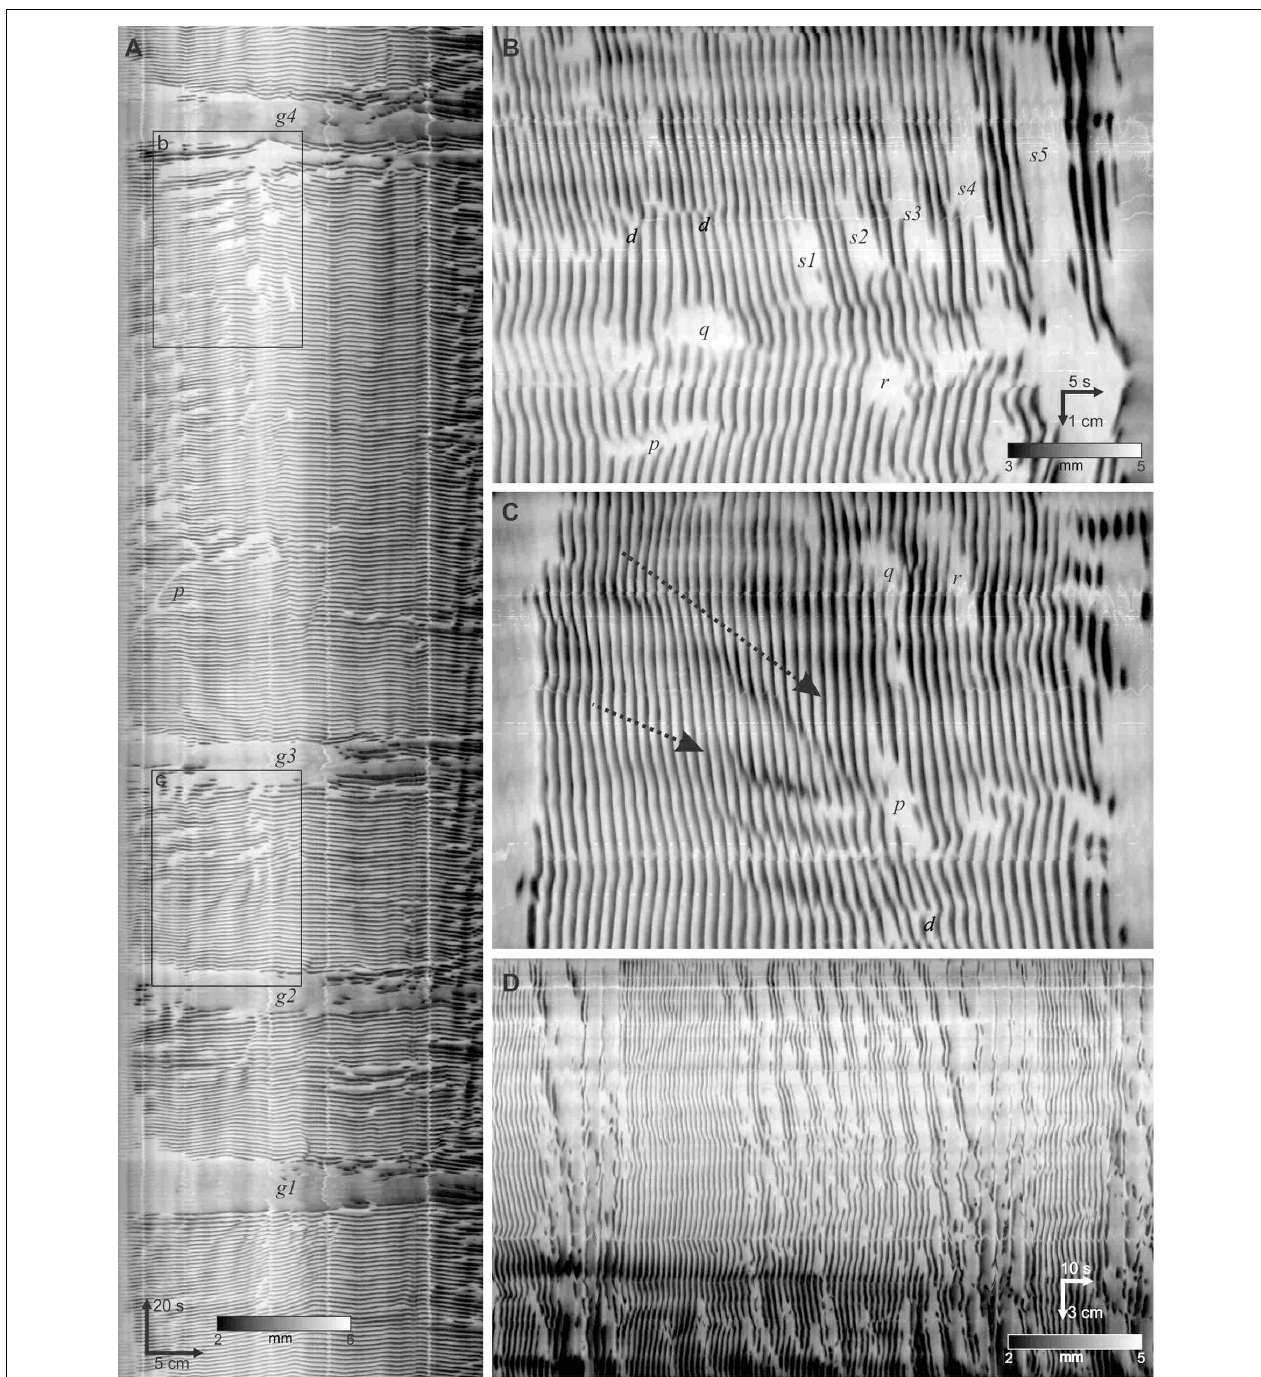
FIGURE 2 | Contraction clusters and other phenomena in the luminally perfused murine small intestine. (A) An 8-min diameter map (DMap) of a small intestine, from the hepatoduodenal ligament to 31 cm distal. Arrows on the spatiotemporal scale ( bottom left ) indicate the direction of time and the proximal to distal axis. The intensity scale ( bottom ) gives the diameter of the intestine. The DMap shows three complete clusters demarcated by gaps g1 - g4 . p indicates a y-shaped inhibitory patch. The four white stripes parallel with the time axis correspond to Peyer’s patches that increase diameter at those points. (B) Box b from panel (A) . p - r are isolated inhibitory patches. s1 - s5 are a rhythmic series of inhibitory patches. d are fork dislocations (just above letter). (C) Box c from panel (A) . p - r are isolated inhibitory patches. d are dislocations. The dotted arrows indicate propagation of dark bands. The scaling is the same as (B) . (D) Ten second rhythm in a different intestine from panels (A–C)